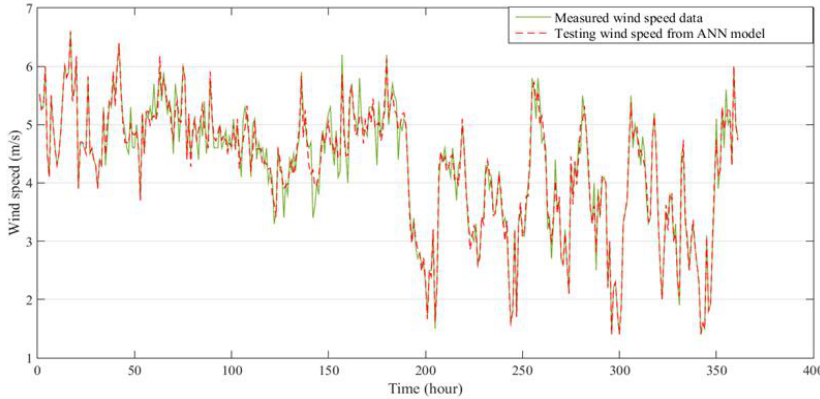
Figure 12. Comparison between measured and predicted wind speed for two weeks at Mersing in 2015, for validation of the ANN model.